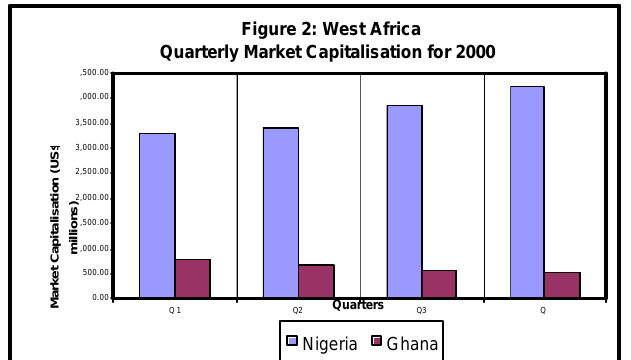
Figure 2: West Africa Quarterly Market Capitalisation for 2000